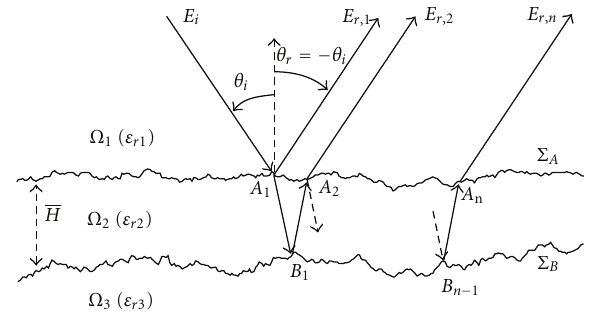
Figure 1: Electromagnetic wave scattering from a 1D random rough layer with two rough surfaces: representation of the first two scattered fields E r ,1 and E r ,2